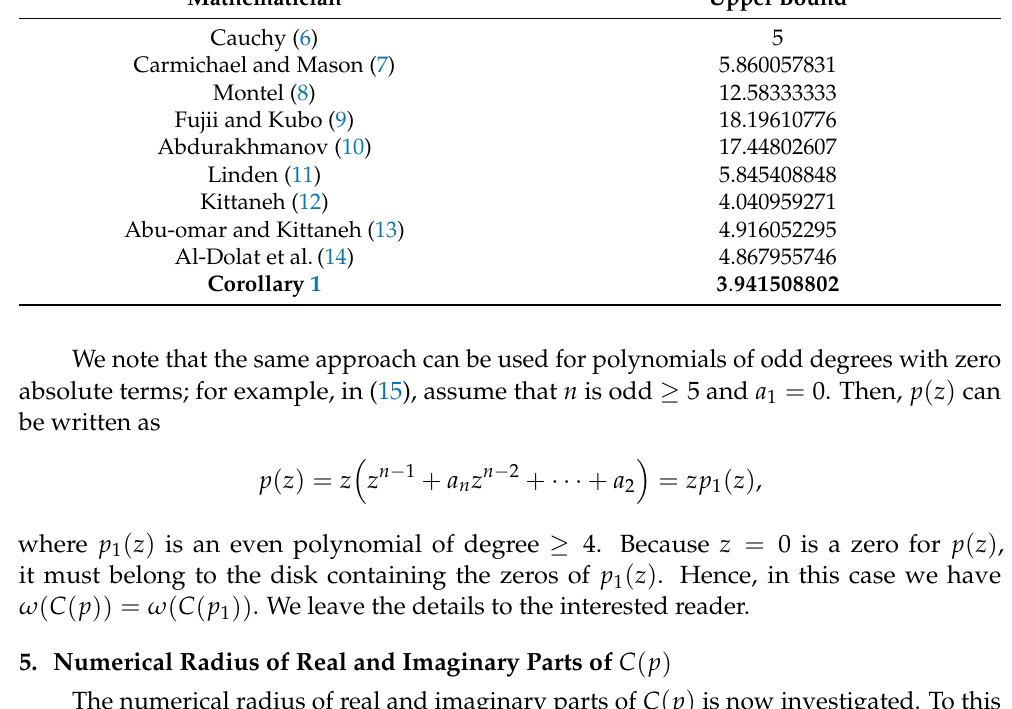
Table 1. Comparisons of upper bounds based on the considered polynomial q 1 ( z ) .